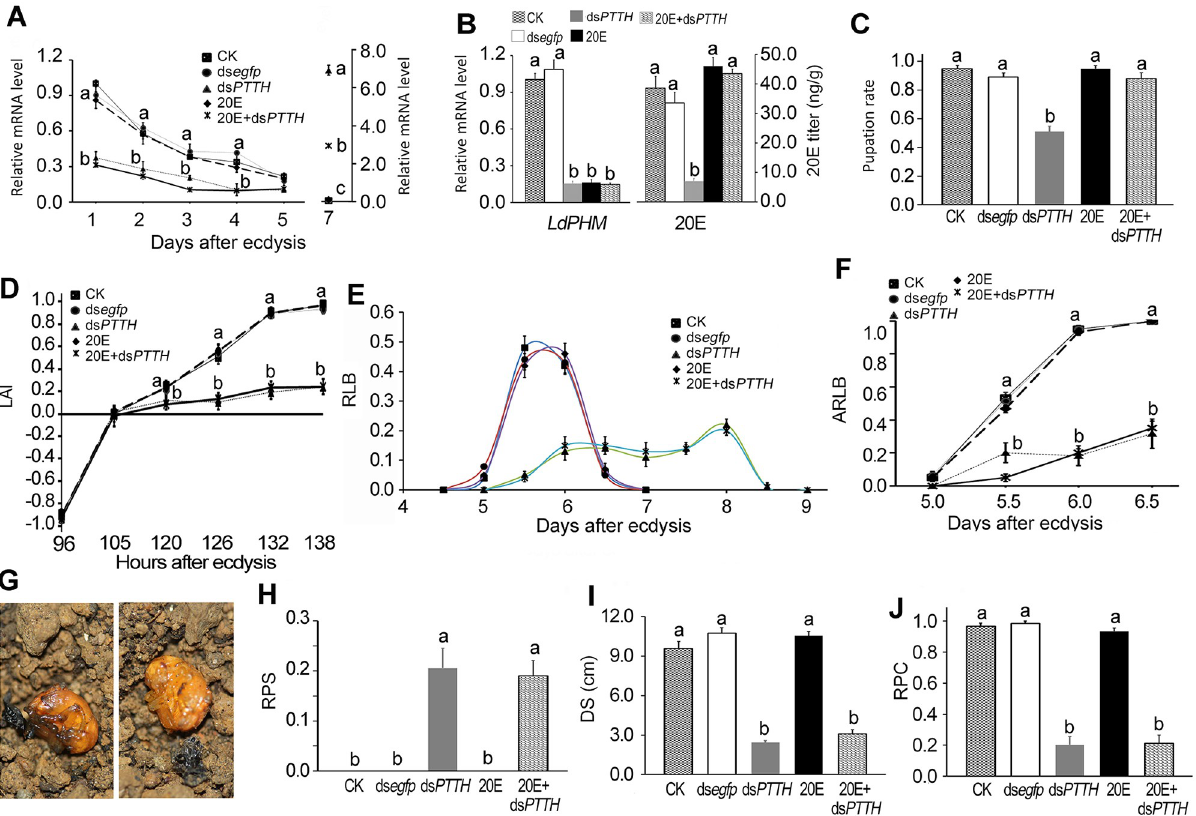
Fig 3. PTTH signal promotes light avoidance of the wandering larvae. PBS (CK), ds egfp , ds PTTH , 20E and ds PTTH +20E were dietarily introduced to the larvae. LdPTTH mRNA level (three repeats) (A), light avoidance index (LAI) (D), rate of larvae that had buried in soil per day (RLB) (E), and accumulated RBP (ARLB) (F) were determined at each testing time point demonstrating in Fig. LdPHM mRNA level and 20E titer (B) were tested at day 1 of the fourth-instar larvae. Pupation rate (C), rate of pupae at the soil surface (RPS) (G, H), average depths from pupation site to soil surface (DS) (I), and rate of pupae that had constructed pupation chambers (RPC) (J) were measured at the end of the experiment (P < 0.05). Significant differences between blank control larvae (CK) and treatments are indicated by different letters (P < 0.05).